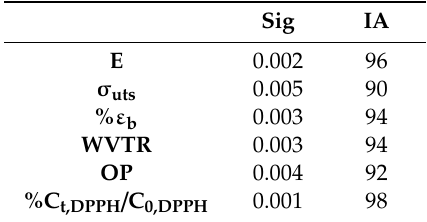
Table 3. Mean values’ inequality test of modulus of elasticity (E), tensile strength ( σ uts ), % elongation